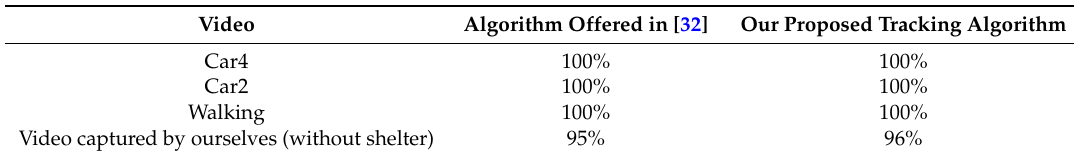
Table 3. Tracking accuracy of the algorithms.